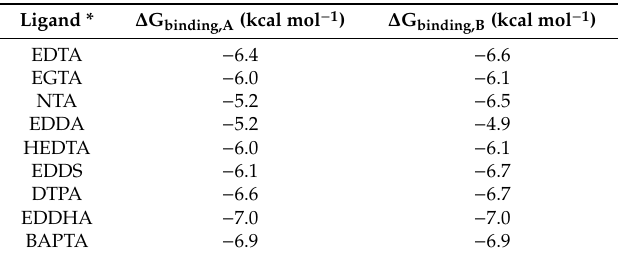
Table 2. Binding free energies calculated by molecular